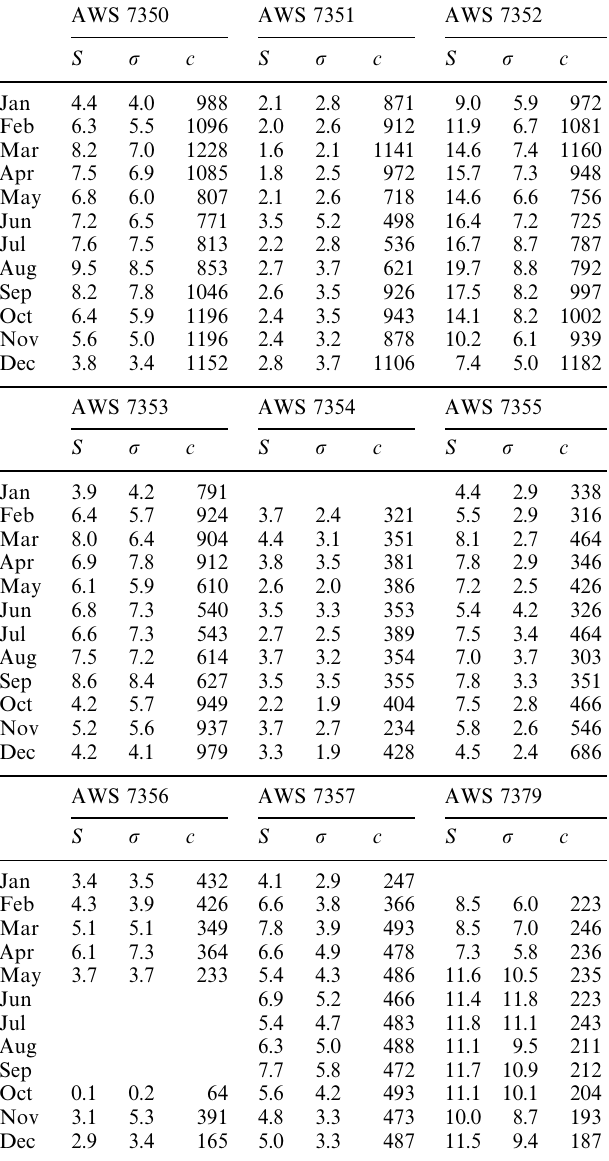
It can be observed that temperature gradient is greater than the normal lapse rate at middle latitudes ( " 0.0065 ° C/m). To this purpose, it should be noticed that the lapse rate was reconstructed from observations at ground level, where air is close to ice or frozen soil and thus cold and dense, rather than from data in the